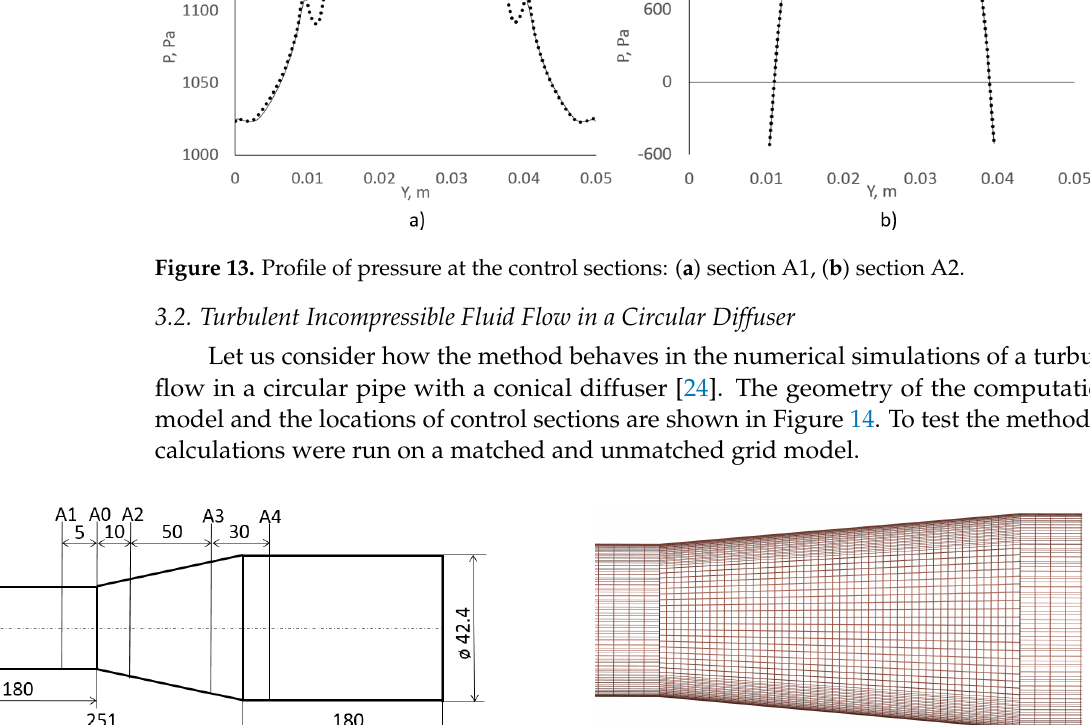
Figure 12. Profile of velocity at the control sections: ( a ) section A1, ( b ) section A2.